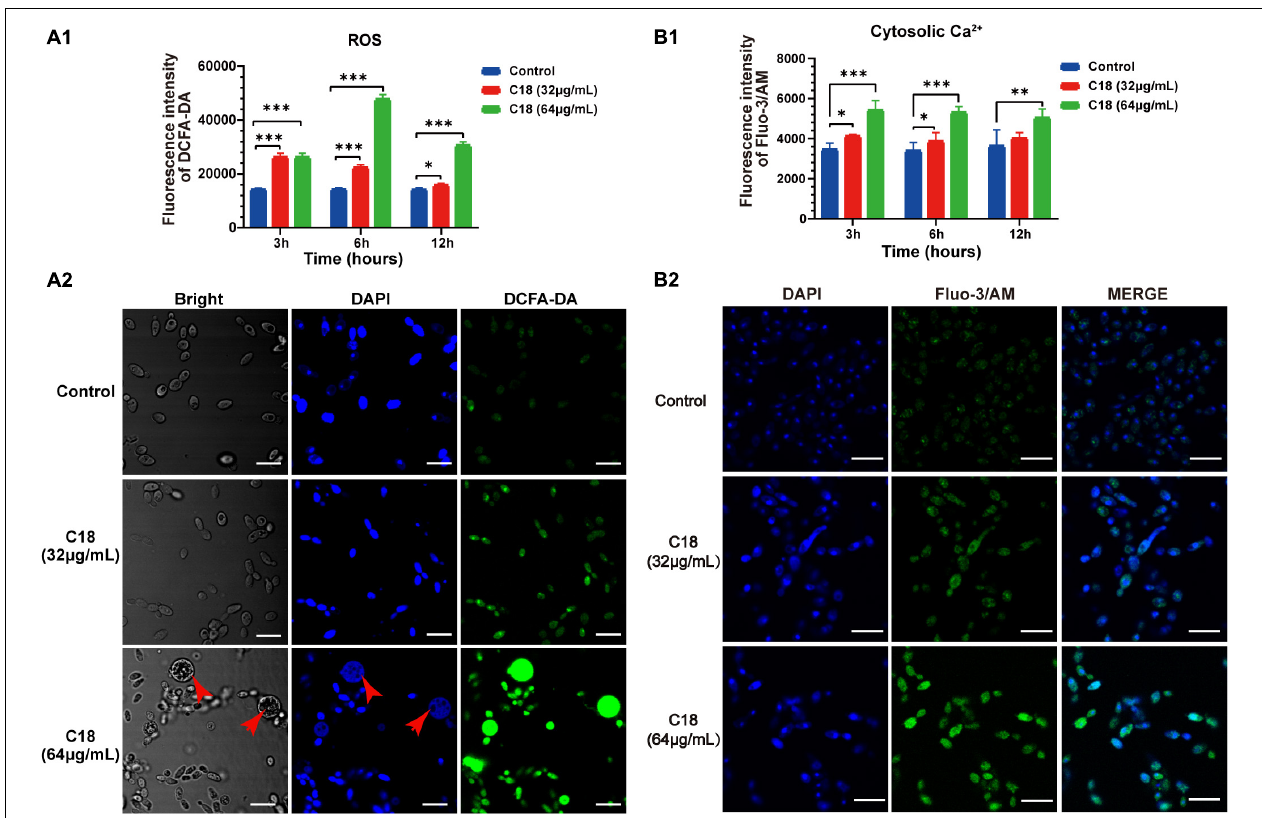
FIGURE 7 | Effect of C18 on intracellular ROS generation and Ca 2 + accumulation of Candida albicans . (A1,B1) Bar diagram showed the level of intracellular ROS and Ca 2 + in C. albicans treated with C18 at concentrations of 32 µ g/ml and 64 µ g/ml. The fluorescence intensity of dichlorofluorescein (DCF; indicates ROS) or Fluo-3/AM (indicates cytosolic Ca 2 + ) was detected by sectrofluoro-photometer, respectively. Error bars represent standard deviation of three independent experiments. ∗∗ p < 0.01, ∗ p < 0.05 , ∗∗∗ p < 0.001 compared to the control group. (A2–B2) Fluorescence images of C. albicans cells stained by 2 (cid:48) ,7 (cid:48) -dichlorofluorescein diacetate (DCFH-DA) or Fluo-3/AM was captured by CLSM after C18 treatment for 6h respectively. Blue represents cell nucleus stained by 4 (cid:48) ,6-diaminidino-2-phenylindole (DAPI), while green represents ROS accumulation (A2) and cytosolic Ca 2 + (B2) , the merge shown in both green and blue are combined from the two channel images. Red arrow indicates dispersive or degradative DNA with DAPI staining in the high level of ROS expression cells. Scale bar 10 µ